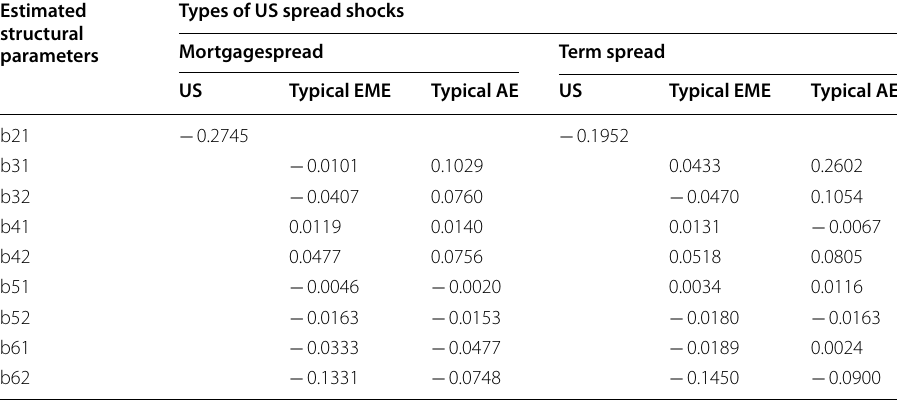
Table 3 The point estimates of the SVAR